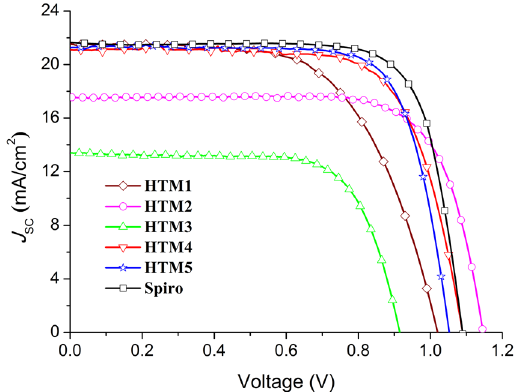
Figure 6. Current ( J )-voltage ( V ) curves of the solar cells with HTM1–5 , and Spiro-OMeTAD (control) recorded under AM 1.5 conditions (100 mW/cm 2